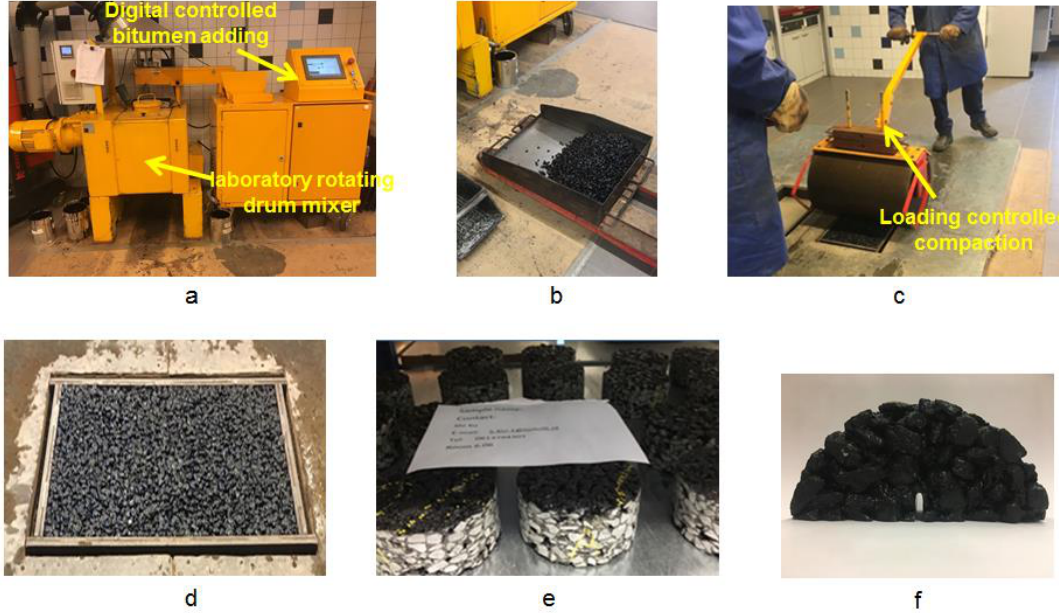
Figure 3. Porous asphalt slab preparation procedure: ( a ) mixing in laboratory rotating drum mixer; ( b ) weighing the mixture; ( c ) compaction with manually roller compactor; ( d ) prepared porous asphalt slab; ( e ) cylinder samples for ITSM tests and ( f ) semi-circular sample for SCB tests.